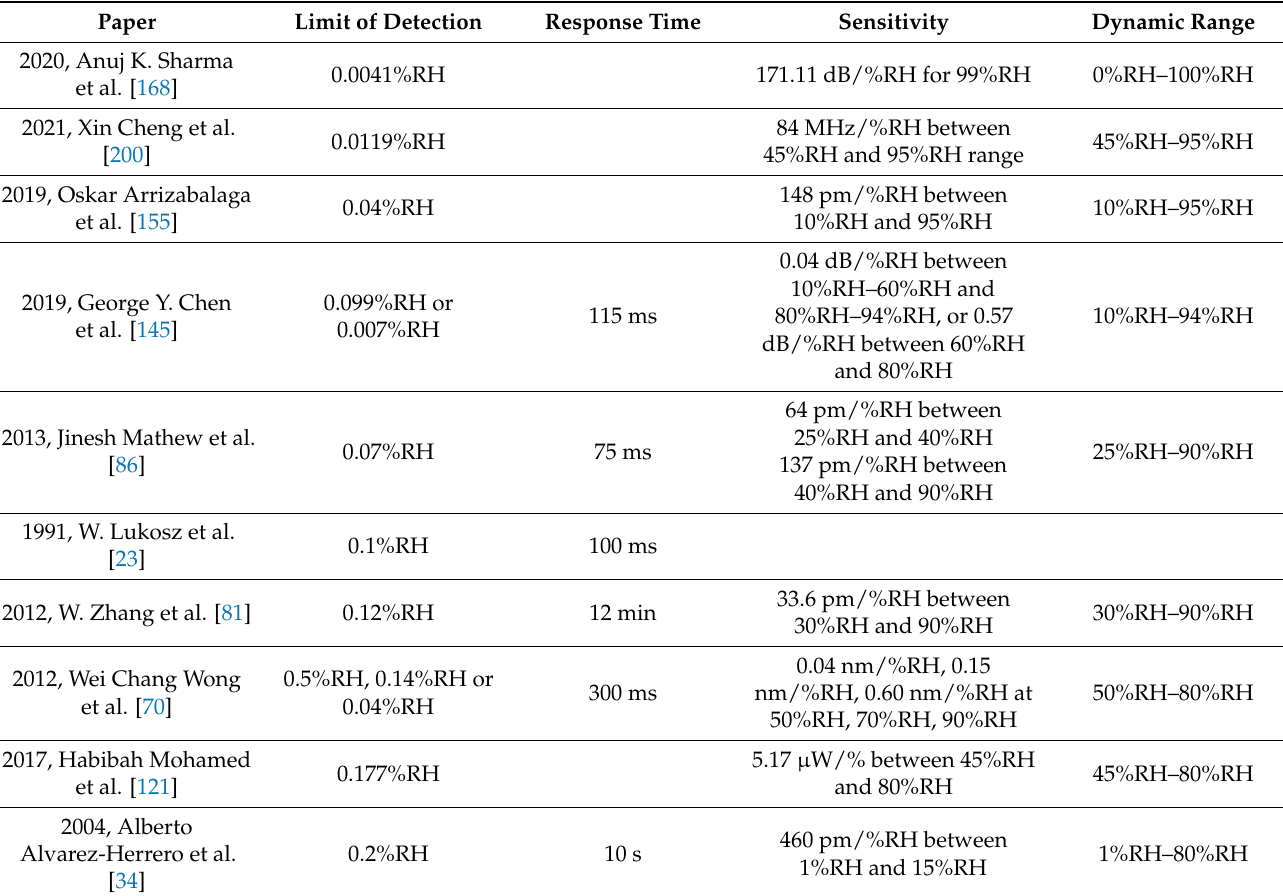
Table 1. Ranking of limit of